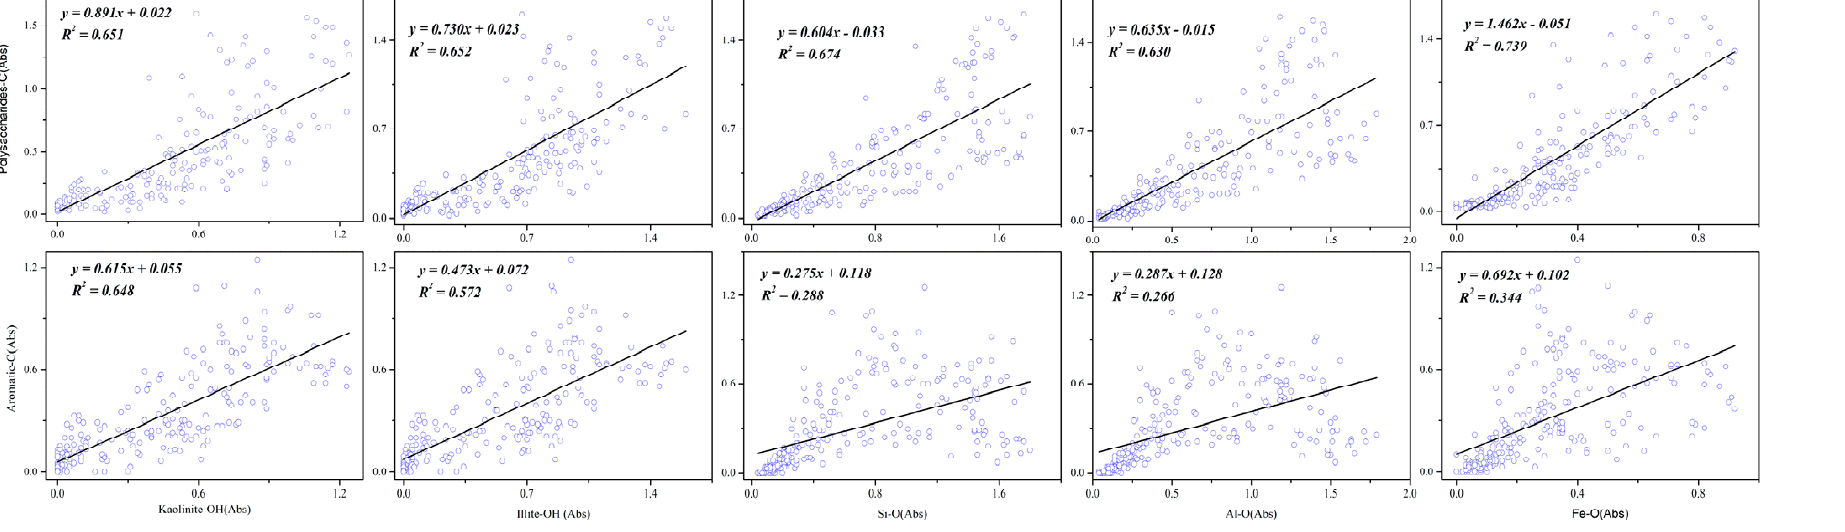
Figure 3. Correlation analysis between organic functional groups and minerals of the CK samples. Data were extracted from Figure 1 using Omnic 9.0 (Thermo Fisher Scientific Inc., Waltham, MA, USA). Table 3. The Correlation analysis between organic functional groups and minerals in soil aggregates as affected by different fertilizer treatments using SR-FTIR.